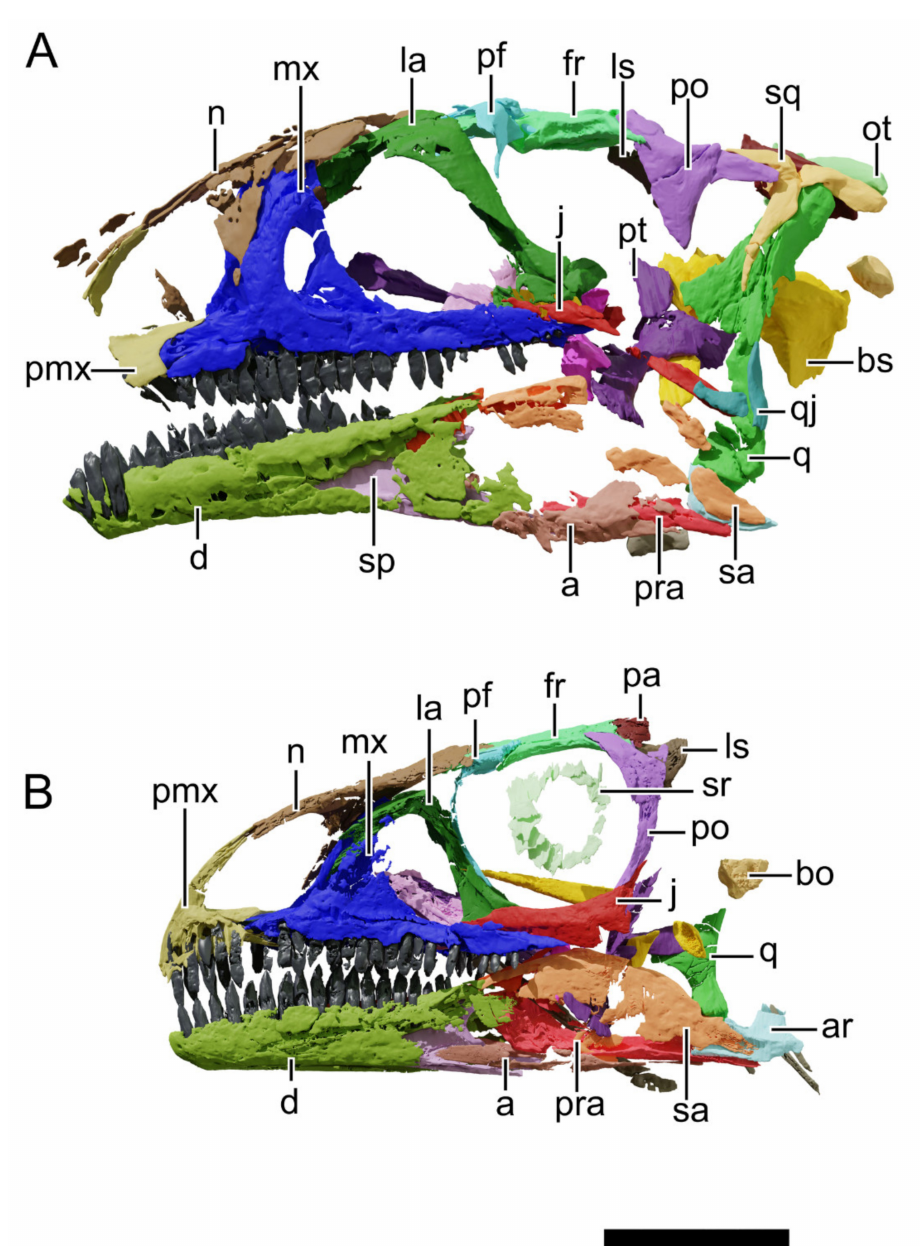
Figure 37. Digital reconstruction of the skulls NHMD 164741 and NHMD 164758 in articulation. Digital arrangement of preserved bone elements of NHMD 164741 ( A ) and NHMD 164758 ( B ) in left lateral view. Abbreviations: ar, articular; bo, basioccipital; bs, basisphenoid; d, dentary; fr, frontal; j, jugal; la, lacrimal; ls, laterosphenoid; mx, maxilla; n, nasal; ot, otoccipital; pf, prefrontal; pmx, premaxilla; po, postorbital; pra, prearticular; pt, pterygoid; q, quadrate; qj, quadratojugal; sa, surangular; sp, splenial; sq, squamosal; sr, sclerotic ring. Scale bar = 50